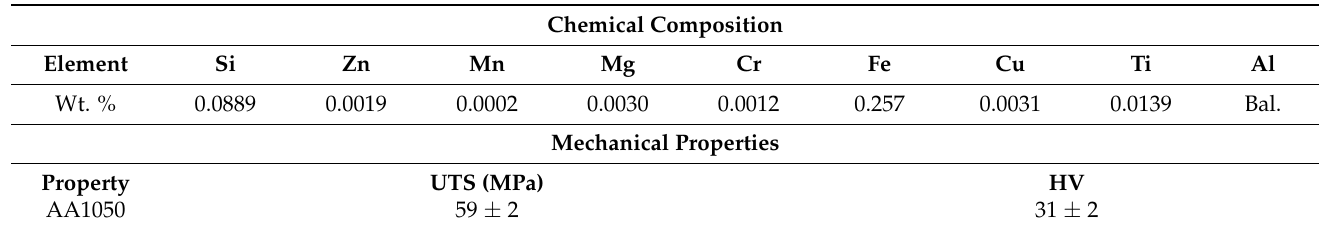
Table 1. The nominal composition and mechanical properties of the as-received AA1050 sheets. Chemical Composition